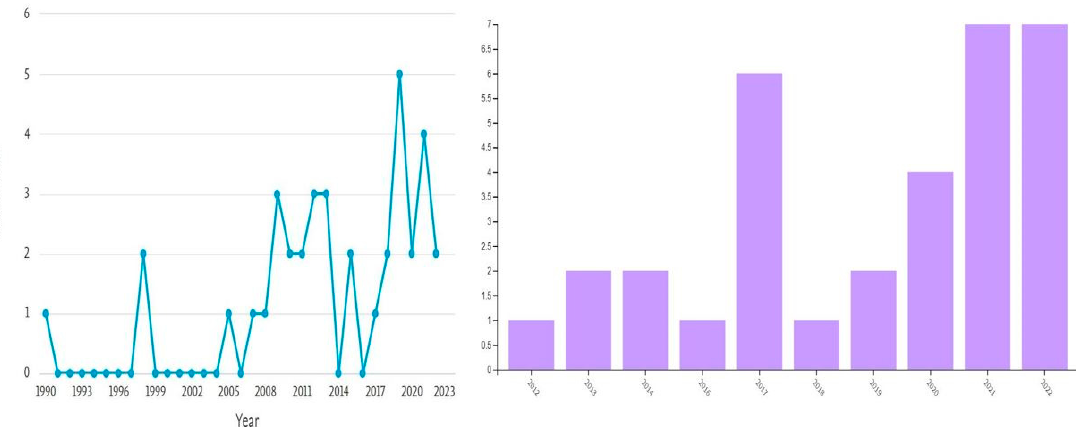
Figure 1. Publications on the topic in the Scopus ( left ) and Web of Science ( right ) databases since the year 1990 (source: Scopus and Web of Science search analysis tools).